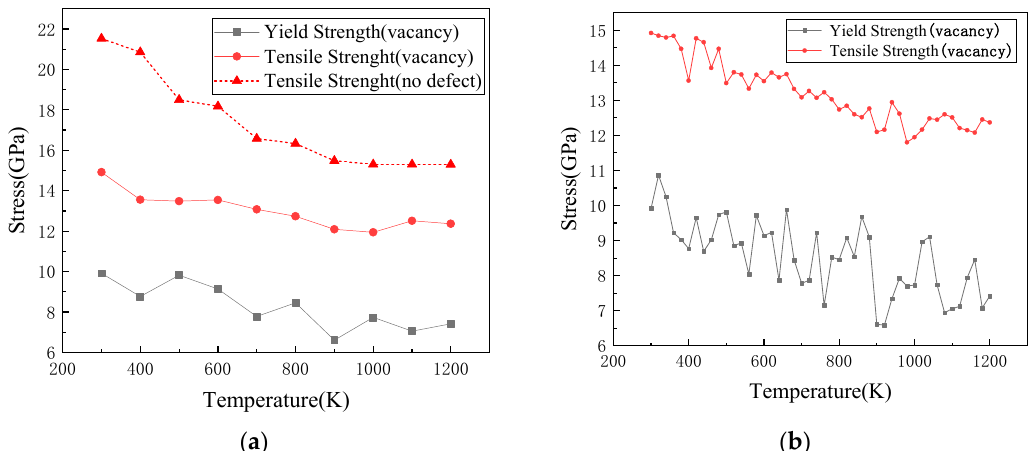
Figure 6. Variations of yield strength and tensile strength of the Si lattice with temperature; ( a ) a temperature increase of 100 K; and ( b ) a temperature increase of 20 K.